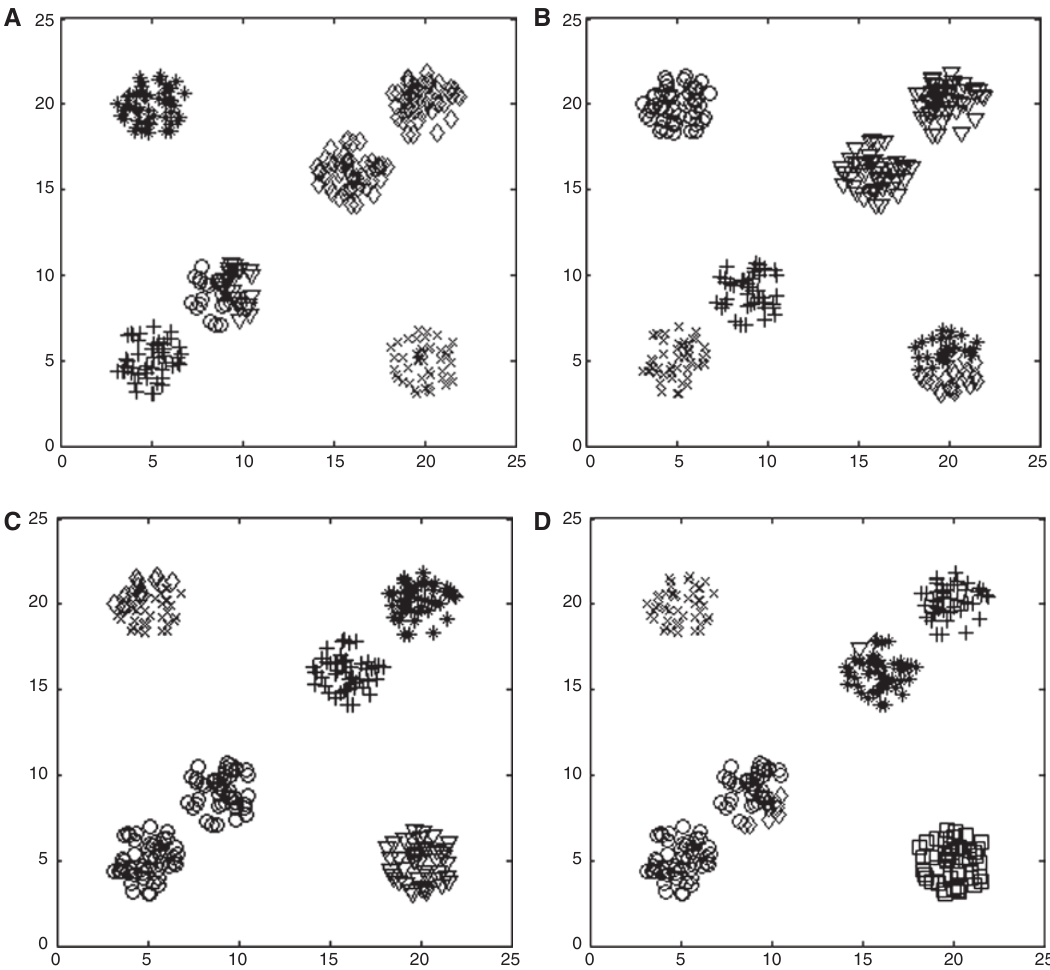
Figure 6: (A) Clustered Spherical_6_2 after the Application of KM for K = 6. (B) Clustered Spherical_6_2 after the Application of FCM for K = 6. (C) Clustered Spherical_6_2 after the Application of MHSC for K = 6. (D) Clustered Spherical_6_2 after the Applica- tion of MHSC for K =